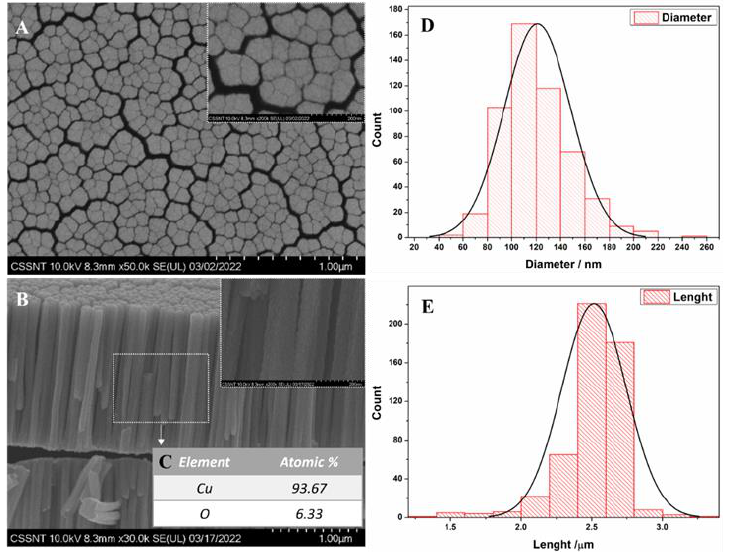
Figure 1 . SEM images of CuNCs: ( A ) top-view; ( B ) cross-section; ( C ) elemental analysis; ( D , E ) their corresponding diameter and length distribution.